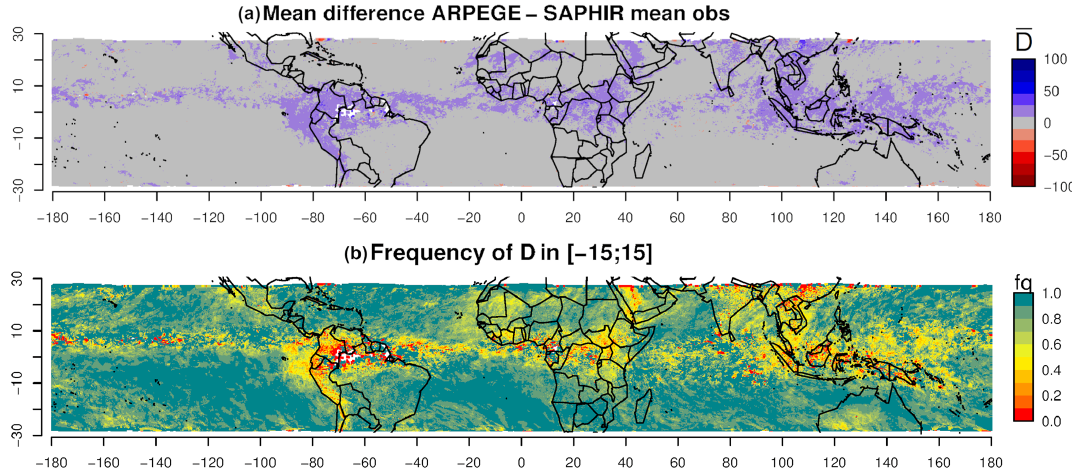
Figure 8. Deterministic comparisons for layer 400–600hPa over the period from April to June 2018. (a) Map of the mean difference